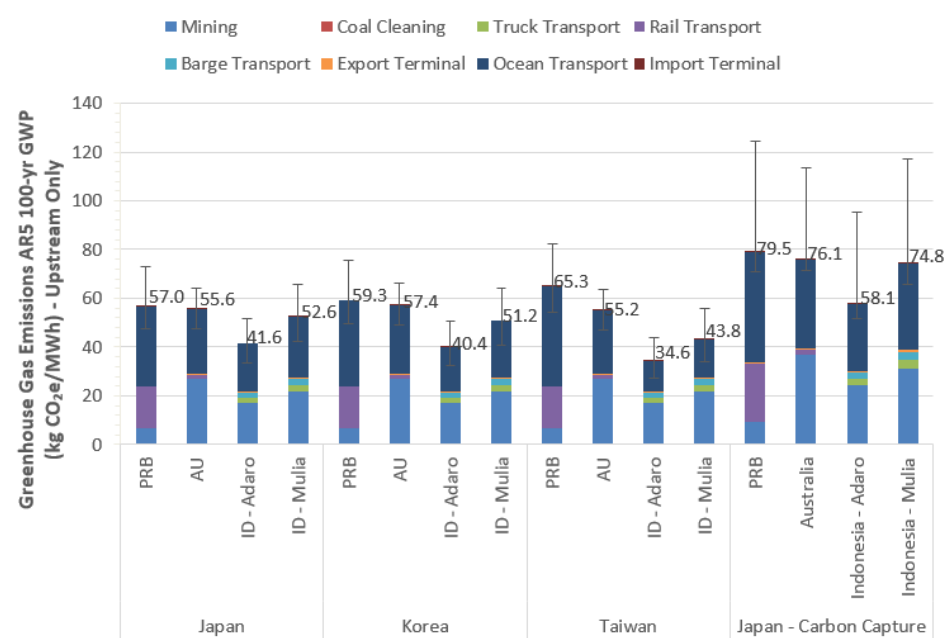
Figure 4. Cradle-to-busbar GHG emissions for U.S. (PRB), Australian (AU), and Indonesian (ID) coals exported to Japan, South Korea (Korea), and Taiwan, with and without 90% CCS. Only the upstream results are shown—power plant and saline aquifer sequestration results are invisible.